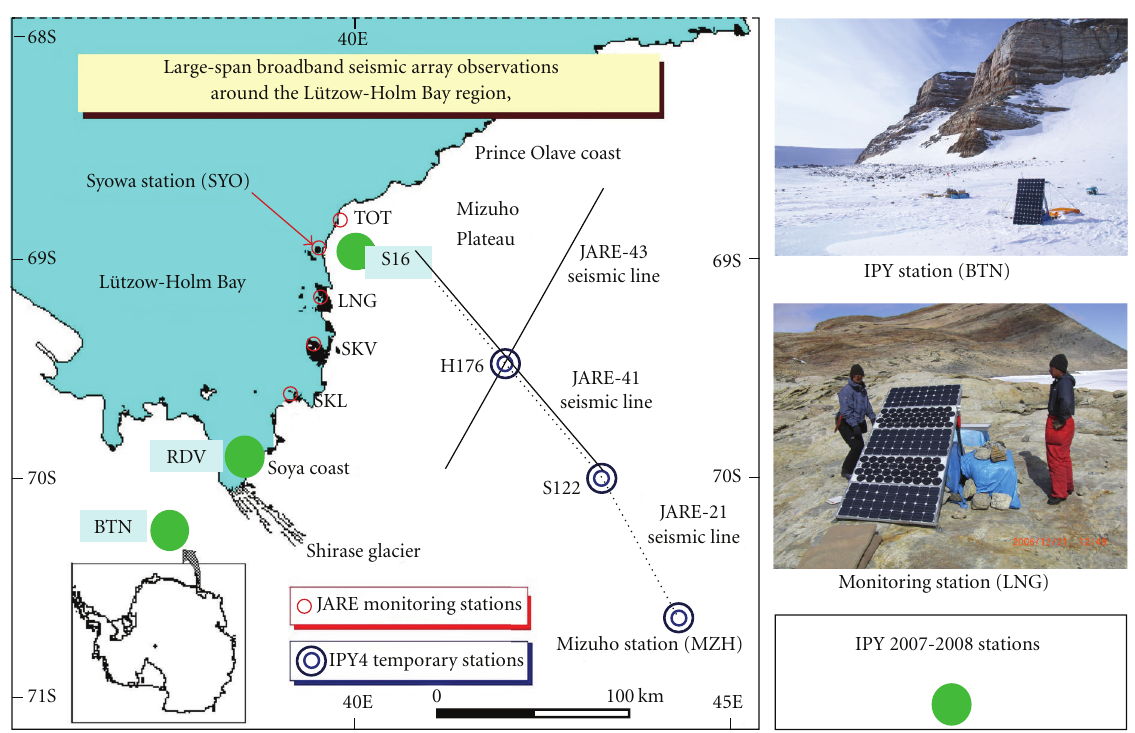
Figure 2: Broadband seismic stations in LHB including IPY period. Monitoring stations (red open circles), IPY stations (green solid circles), and future planned stations (blue double-open circles) are indicated,